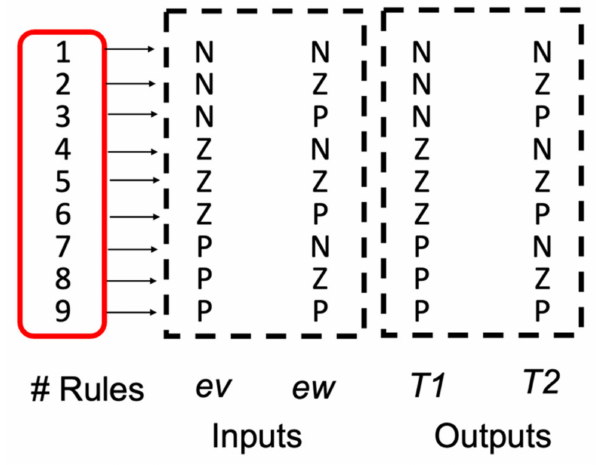
Figure 15. Fuzzy rules of the FC for the AMR